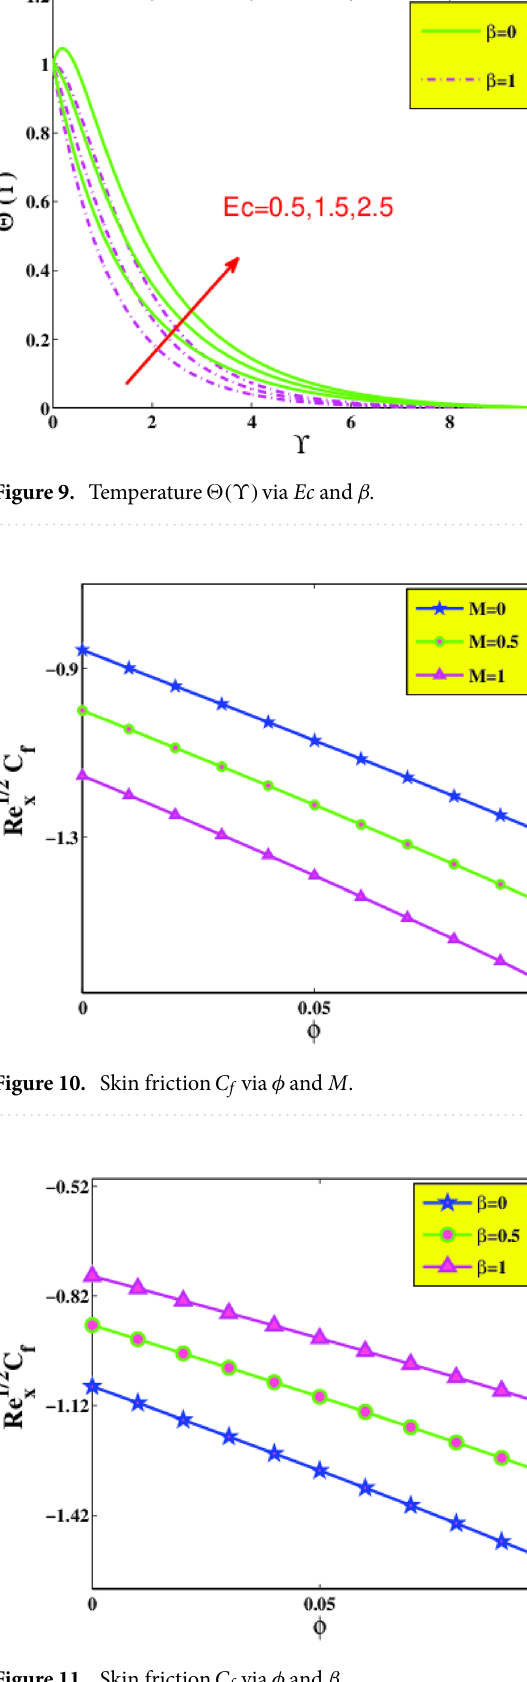
Figure 11. Skin friction C f via φ and β